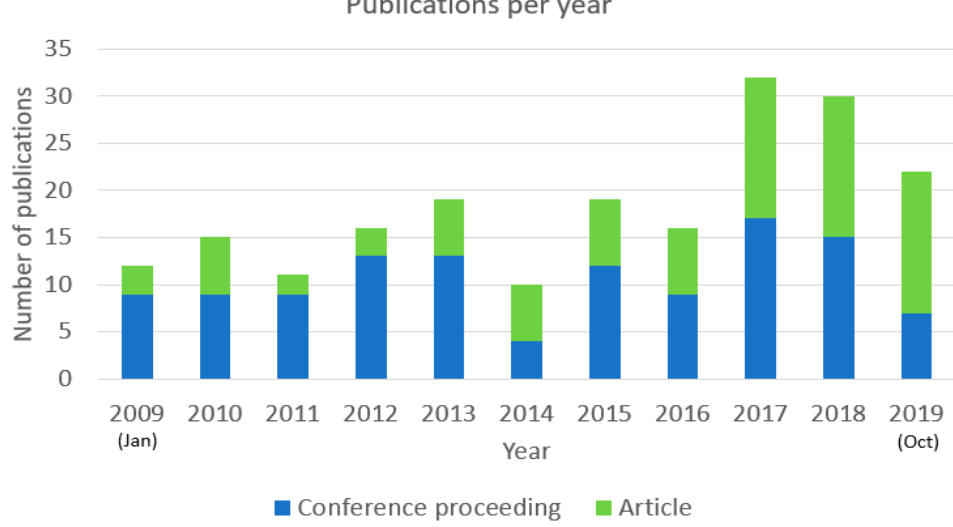
Figure 2. The number of publications (conference proceedings and articles) per year from the period from January 2009 to October 2019. from January 2009 to October